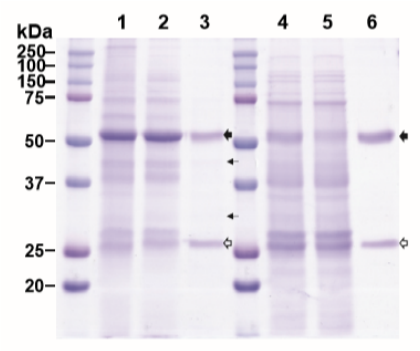
Figure 2. Aqueous two-phase separation (ATPS)-based purification of E16 mAb from N. benthamiana leaves. Total soluble proteins were extracted from plants and E16 was purified by ATPS (Lanes 1–3) or Protein A affinity chromatograph (Lanes 4-6), analyzed on a 12% SDS-PAGE gel under reducing conditions, and visualized with Coomassie stain. Lane 1, total leaf soluble proteins; Lane 2, proteins in the upper aqueous phase of ATPS; Lane 3, ATPS-enriched E16; Lane 4, leaf soluble proteins after low pH precipitation; Lane 5, Protein A flow through; Lane 6, Protein A column-purified E16. : HC,